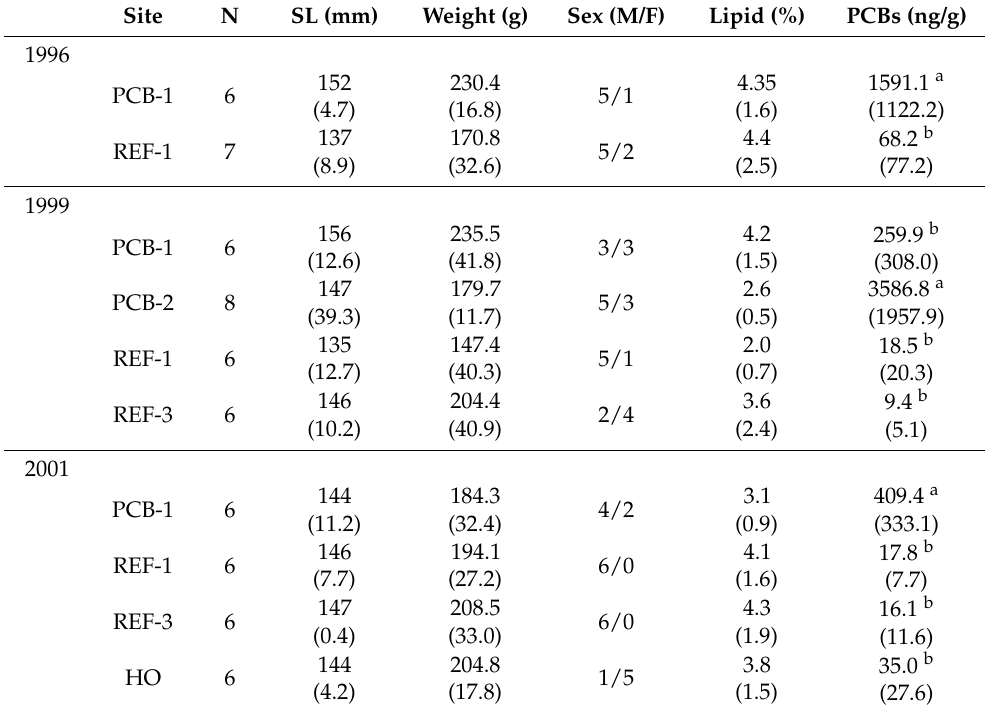
Figure 5. Percent embryo abnormalities occurring at five sites within Johnston Atoll over four years. Note that these are natural log-transformed data.